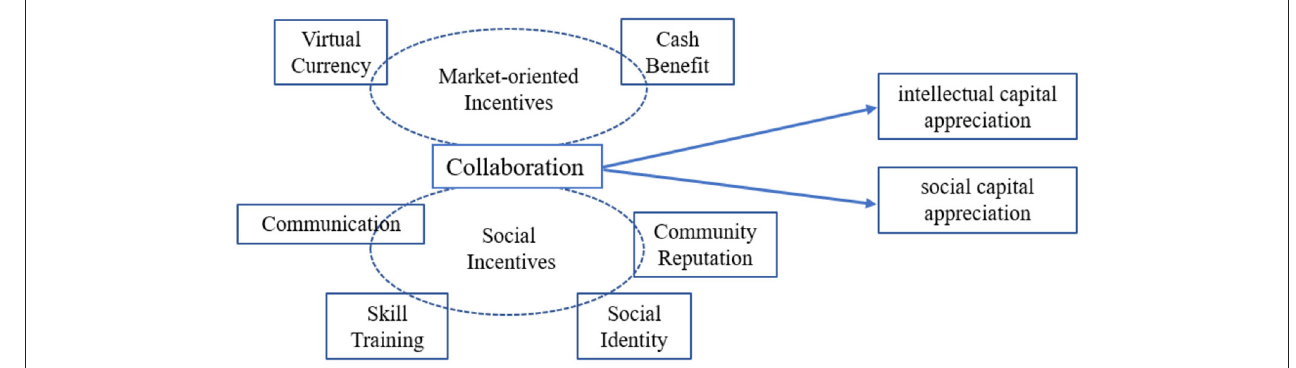
FIGURE 1 | Research